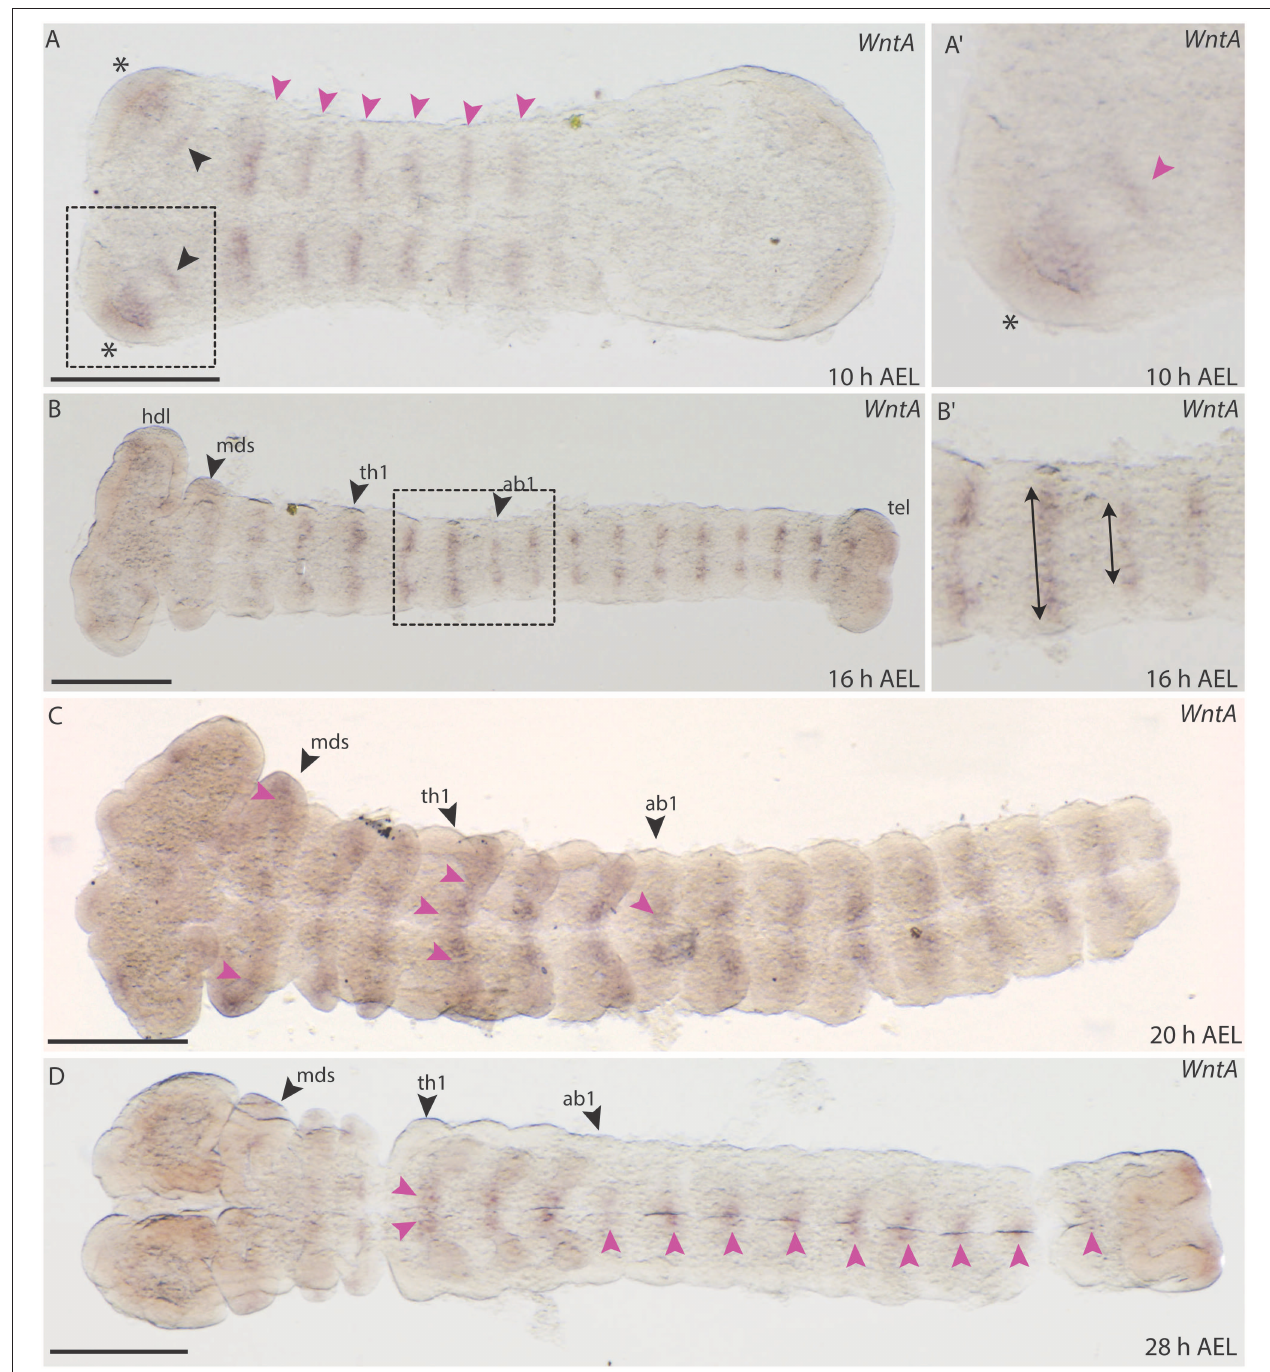
FIGURE 11 | Expression of WntA during the development of B. anynana. (A) Expression in segmental stripes at 10h AEL (pink arrowheads). (A ′ ) Magnification of the head at 10h AEL, expression can be detected in the head lobe (asterisks) and proximal to this domain (pink arrowhead). (B) Expression around 16h AEL, segmental expression labeled by pink arrowheads. (B ′ ) Magnification of segments at 16h AEL indicating the different height of the stripes in the abdominal segments compared to the thoracic segments (arrows). (C) At 20h AEL expression in all segments is still detectable (pink arrowheads). (D) At 28h AEL, small expression domains along the A-P axis at the neurogenic furrow are seen (pink arrowheads). All pictures are orientated with anterior to the left if not otherwise stated. h, hours; AEL, after egg laying; th1, thoracic segment 1; ab1, abdominal segment 1; mds, mandibular segment. Scale bar: 400 µ m.